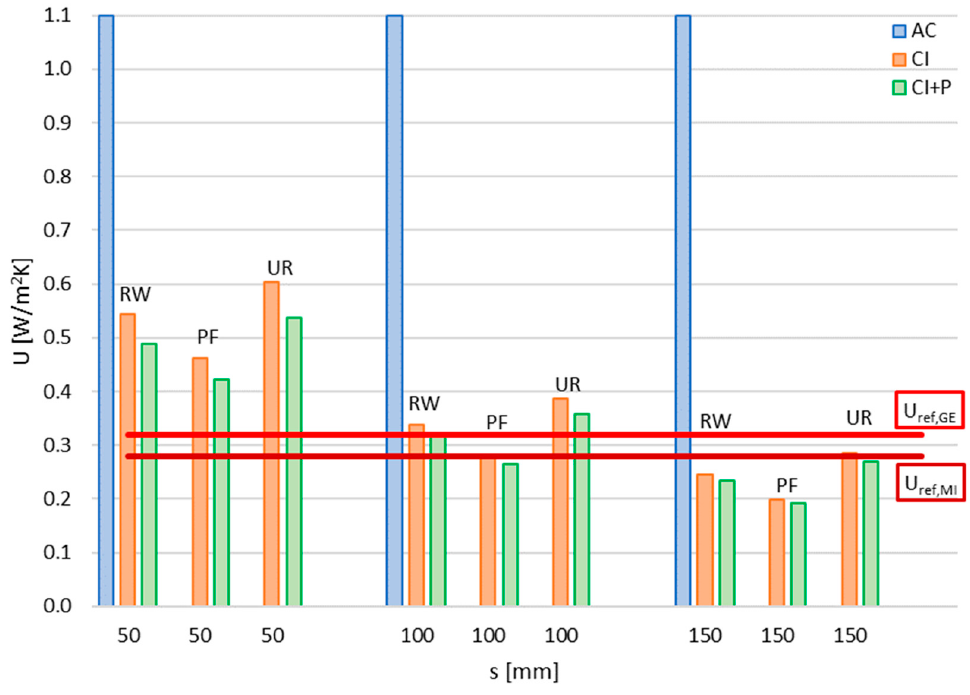
Figure 1. Thermal transmittance U.